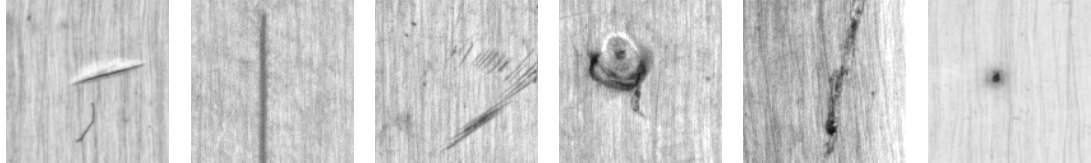
Figure 2. Various defects on the steel surface scans.